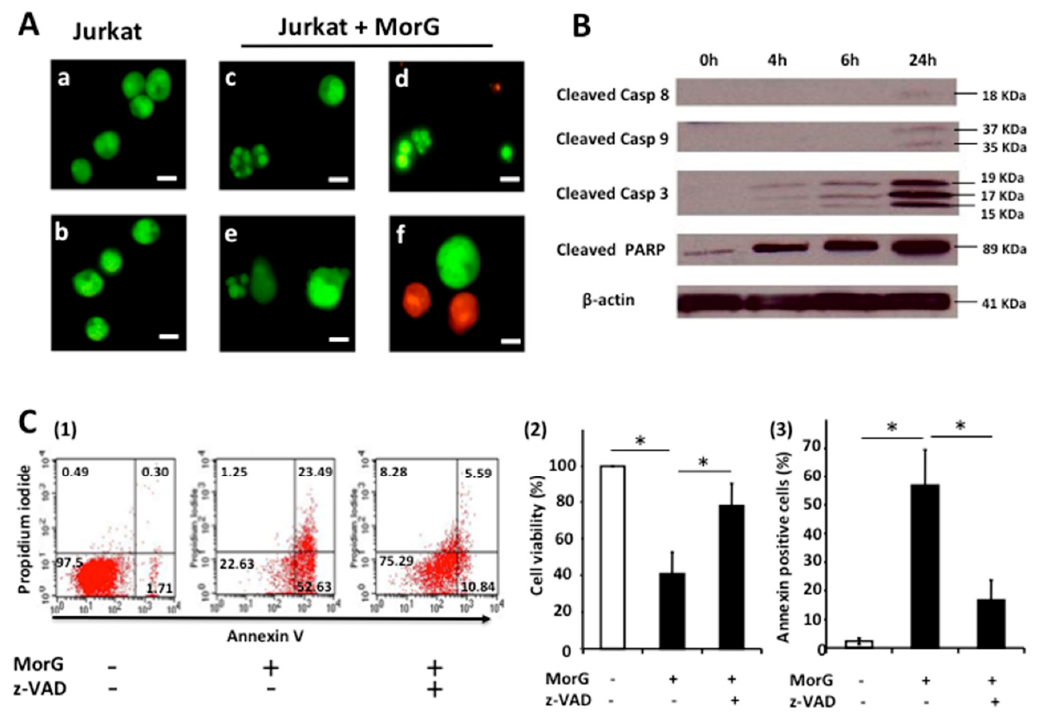
Figure 2. Analysis of Morniga-G-induced cell death in Jurkat leukemic cells. Jurkat A3 leukemic cells were incubated for 24 h with MorG (20 µ g/mL), then analyzed using ( A ) fluorescence microscopy after Syto13 (green fluorescence) + propidium iodide staining (red fluorescence), Scale bars = 10 µ m, ( B ) western blotting after staining with various anti-caspases and anti-PARP mAbs, and ( C ) cytofluorometry after Propidium iodide PI + FITC-annexin staining or MTT assays. ( A , B ) are representative of three identical experiments, ( A ) c and d show apoptotic cells whereas e and f show necrotic cells. ( C ) Cells were incubated with MorG in the presence of absence of z-VAD-fmk, a cell-permeant pan-caspase inhibitor: ( 1 ) cytofluorometric representative experiment, ( 2 ) MTT assays, ( 3 ) PI + FITC-annexin staining. Results are mean ± SD of three independent experiments, * p <